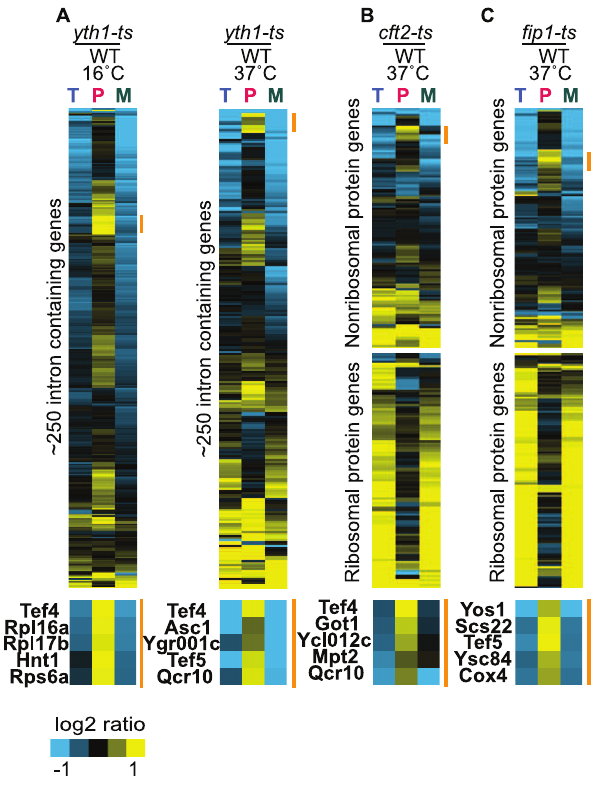
Figure 6. Mutations in 3 9 end processing mutants result in transcript-specific splicing defects. Splicing sensitive microarrays for the cleavage and polyadenylation factor mutants yth1-ts (A), cft2-ts (B), and fip1-ts (C). For each panel, the data have been independently organized using hierarchical clustering. The orange bar highlights the location of specific subsets of transcripts showing splicing defects.